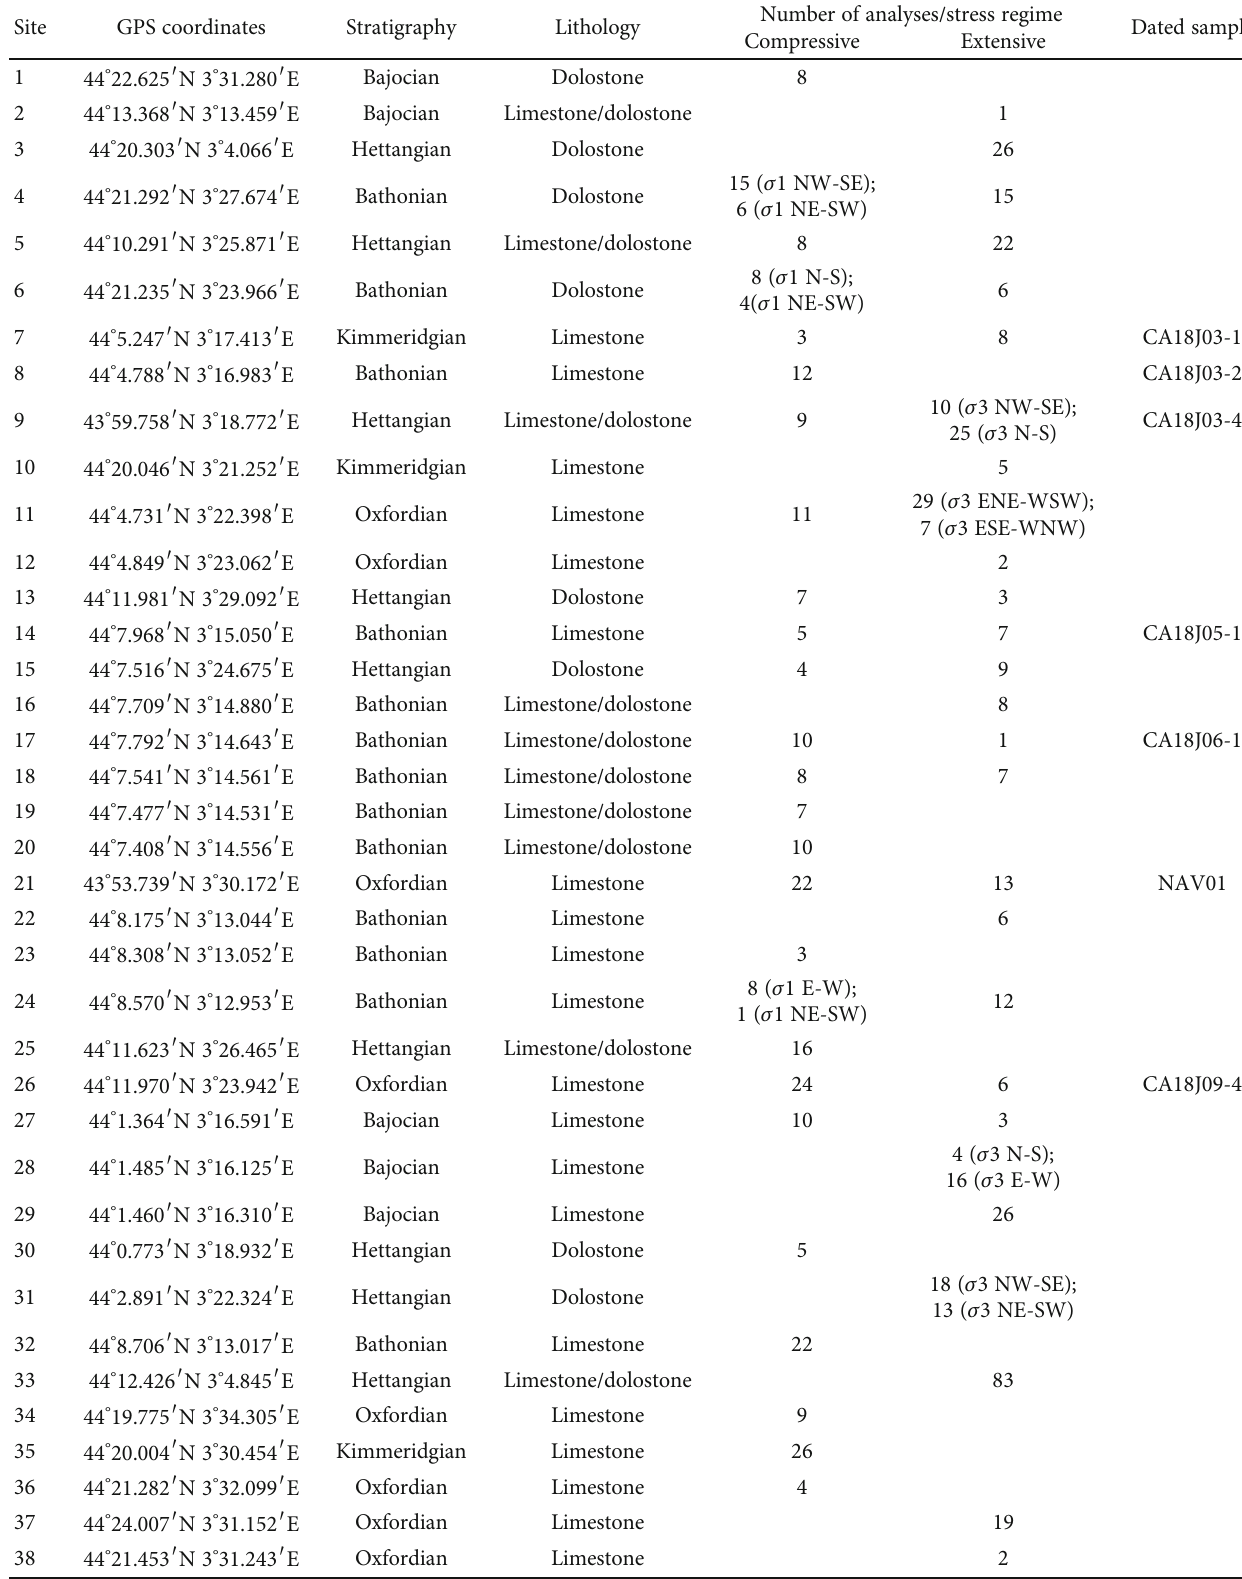
Table 1: Detailed information for microtectonic sites. See Figure 2 for the location of sites and Table 2 for more details about dated samples. The orientation of the main stress is speci fi ed in brackets when two stress regimes are identi fi ed for the same